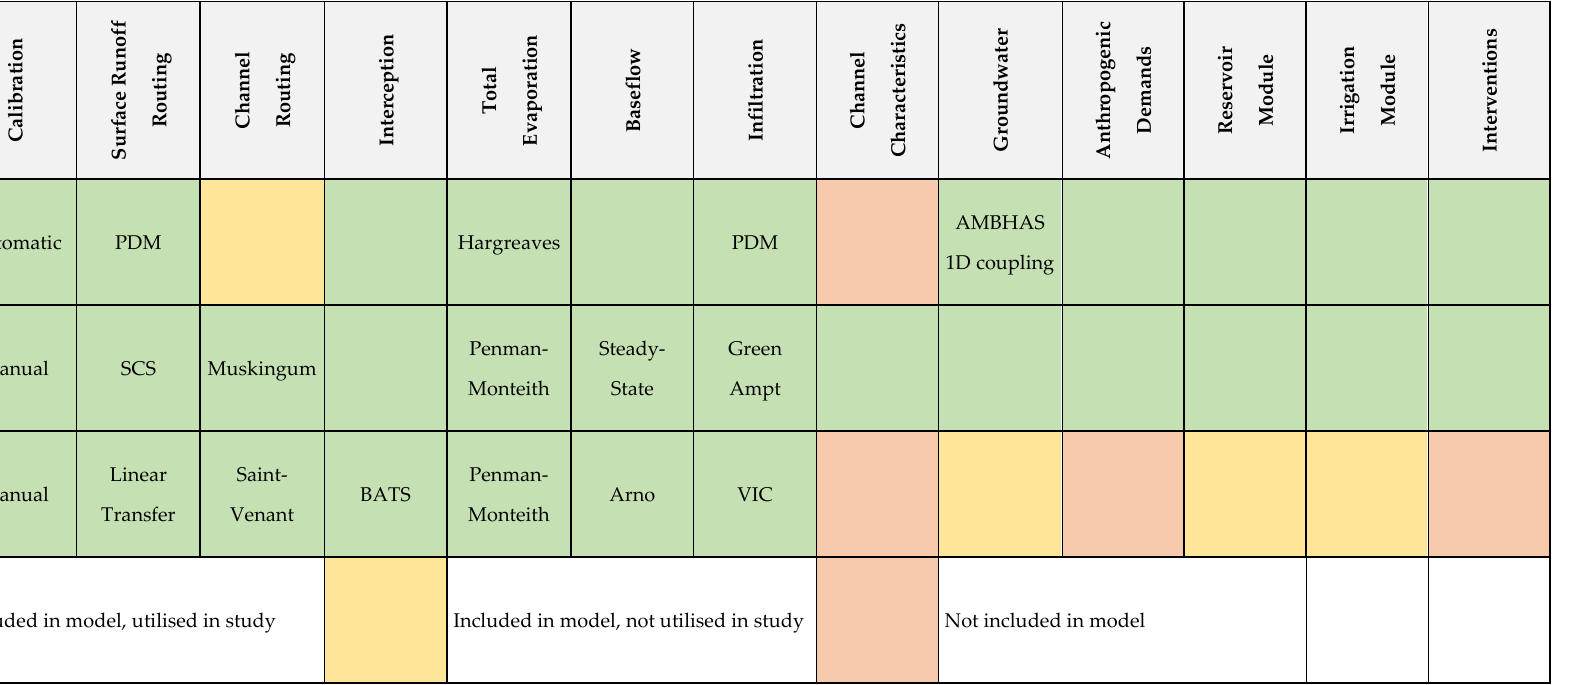
Table A1. Brief Description of functionality/processes summarised from the model user guidance [58,61,63].